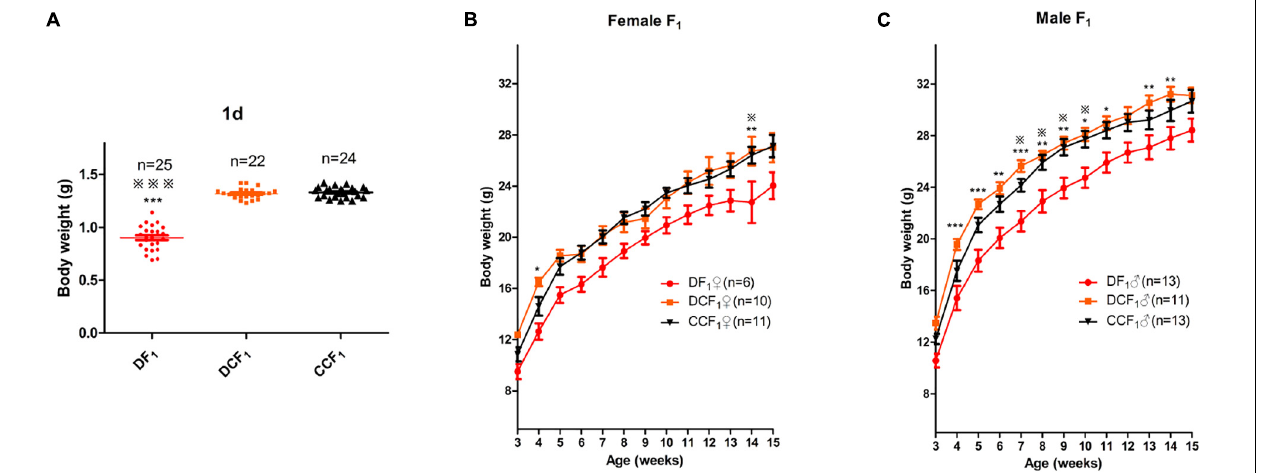
FIGURE 4 | F 1 body weight distributions and trajectories. (A) Scatter plots of the body weight distribution for F 1 at 1 day of age. (B,C) The body weight trajectories of female F 1 (B) and male F 1 (C) mice between 3 and 15 weeks of age. Data are expressed as mean ± S.E.M.; * P < 0.05, ** P < 0.01, *** P < 0.001 DF 1 vs. DCF 1 . Statistical significance, DF 1 vs. CCF 1 , is represented using . There is no statistical significance between DCF 1 and CCF1. A one way ANOVA in (A) and a two-way repeated measurement ANOVA in (B,C) , post hoc Bonferroni multiple-comparisons test was used to assign P -values by comparing to each other. P -values for significance between groups in repeated measure analysis are